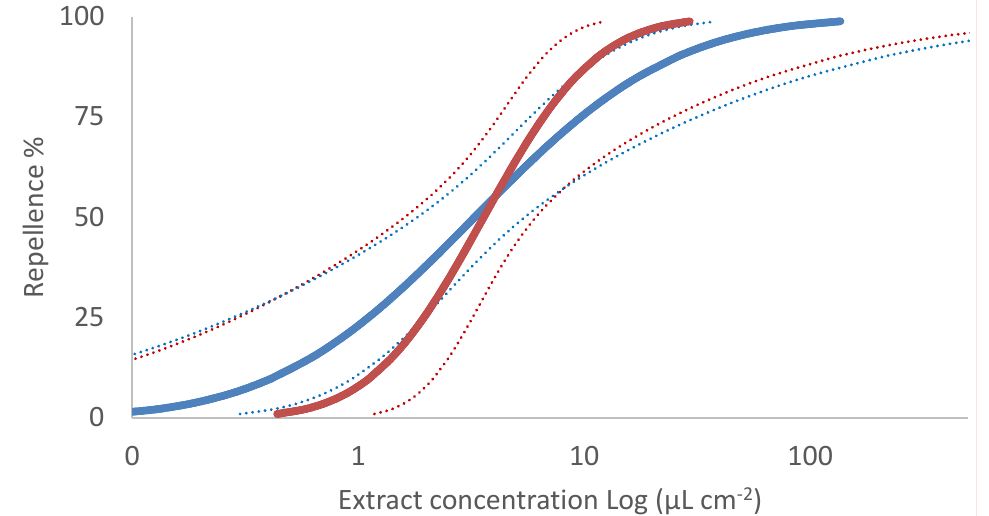
Figure 4. Probit model of the repellent effect (Repellence%) of Lavandin flowers (red line) and stems (blue line) hydrosols against Tribolium confusum adults. Dotted lines indicate 95% confidence intervals. Table 3. Median repellent dose (RD 50 ) of Lavandin flowers and stems aromatic waters and of the synthetic repellent MR-08 against Tribolium confusum adults.